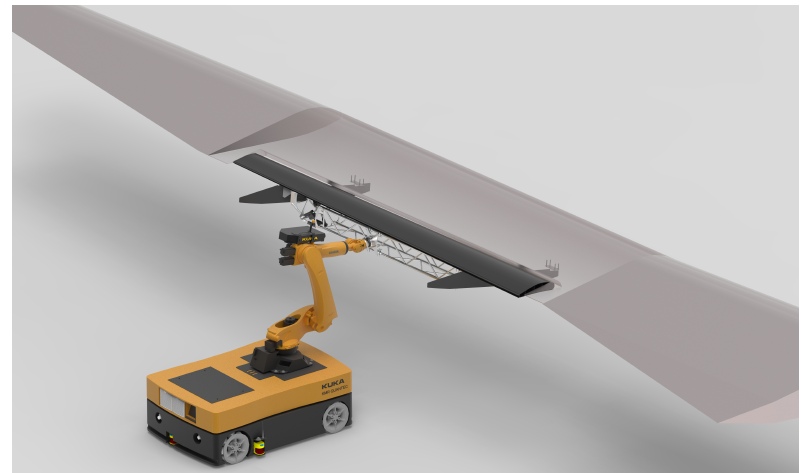
Figure 2. Proposed flap-module assembly scenario featuring an AIMM and a lightweight end effector with shape compensation